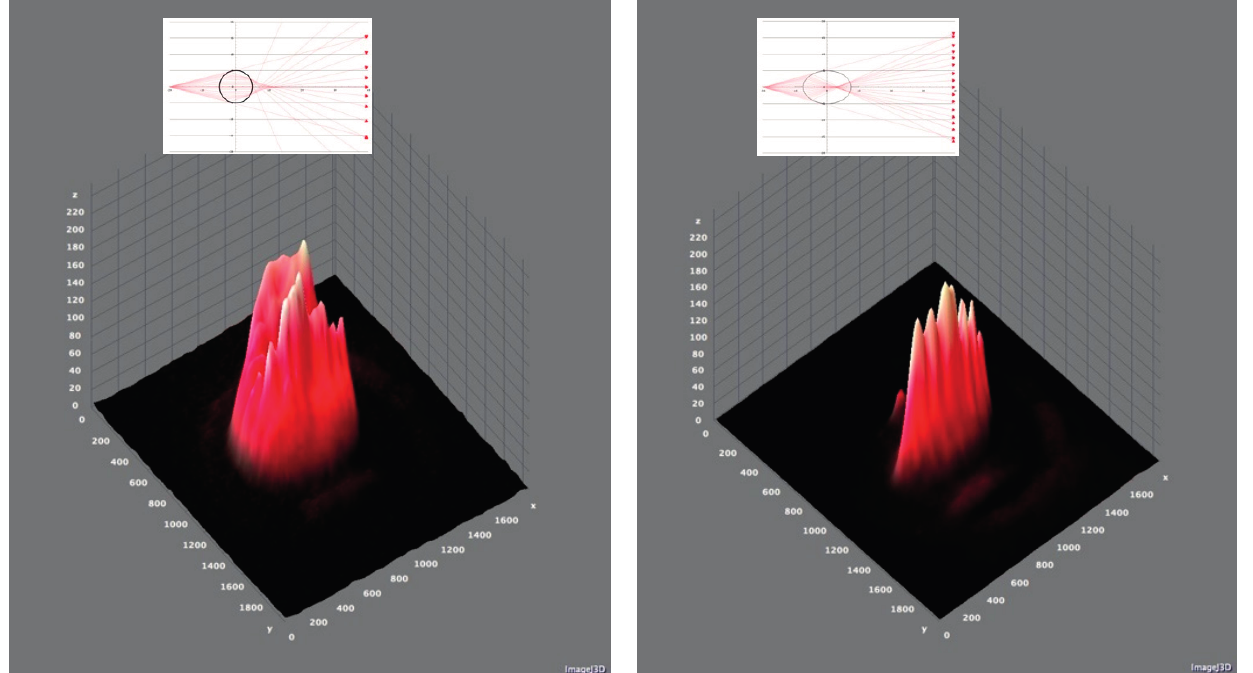
Figure 9. Images of a spherical and an oblate spheroid sample chamber using a red light (620 nm) source in direct line with the camera sensor. The sample chambers are filled with water. The top panels show the images and a histogram of the pixel intensities for the RGB images. 3D renderings of the data and inserts showing 2D ray tracings are given in the lower panels for qualitative comparisons to the graphs in Figure